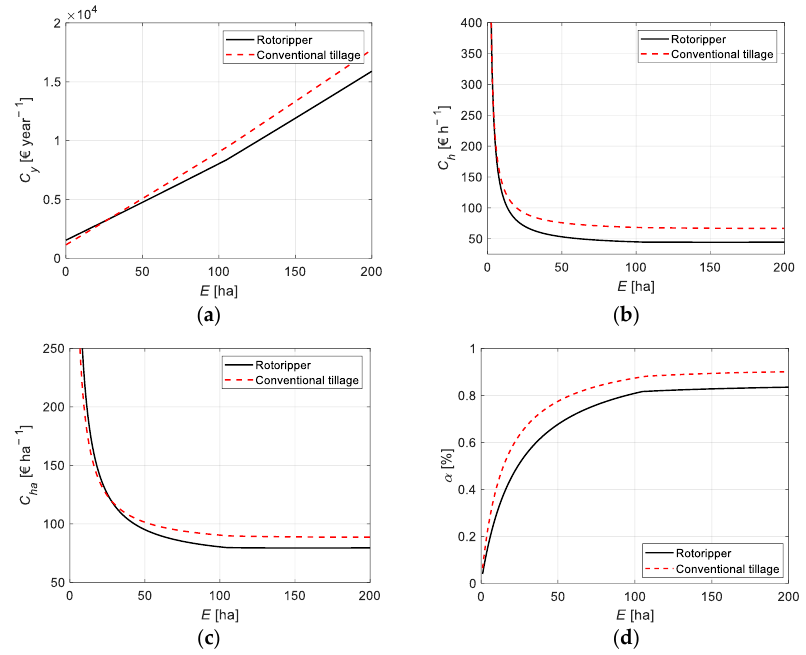
Figure 8. The total cost per year ( C y ) ( a ), the total cost per hour ( C h ) ( b ), the total cost per hectare ( C ha ) ( c ), and the impact of the operational costs on the global ownership costs (α) ( d ).